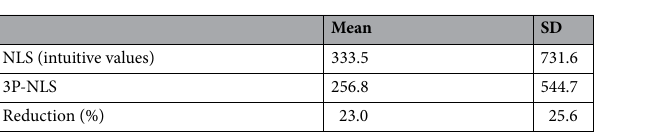
Table 9. Mean number of iterations needed for the NLS fitting using initial intuitive values versus fitting using the values provided by the 3P method as initial values.